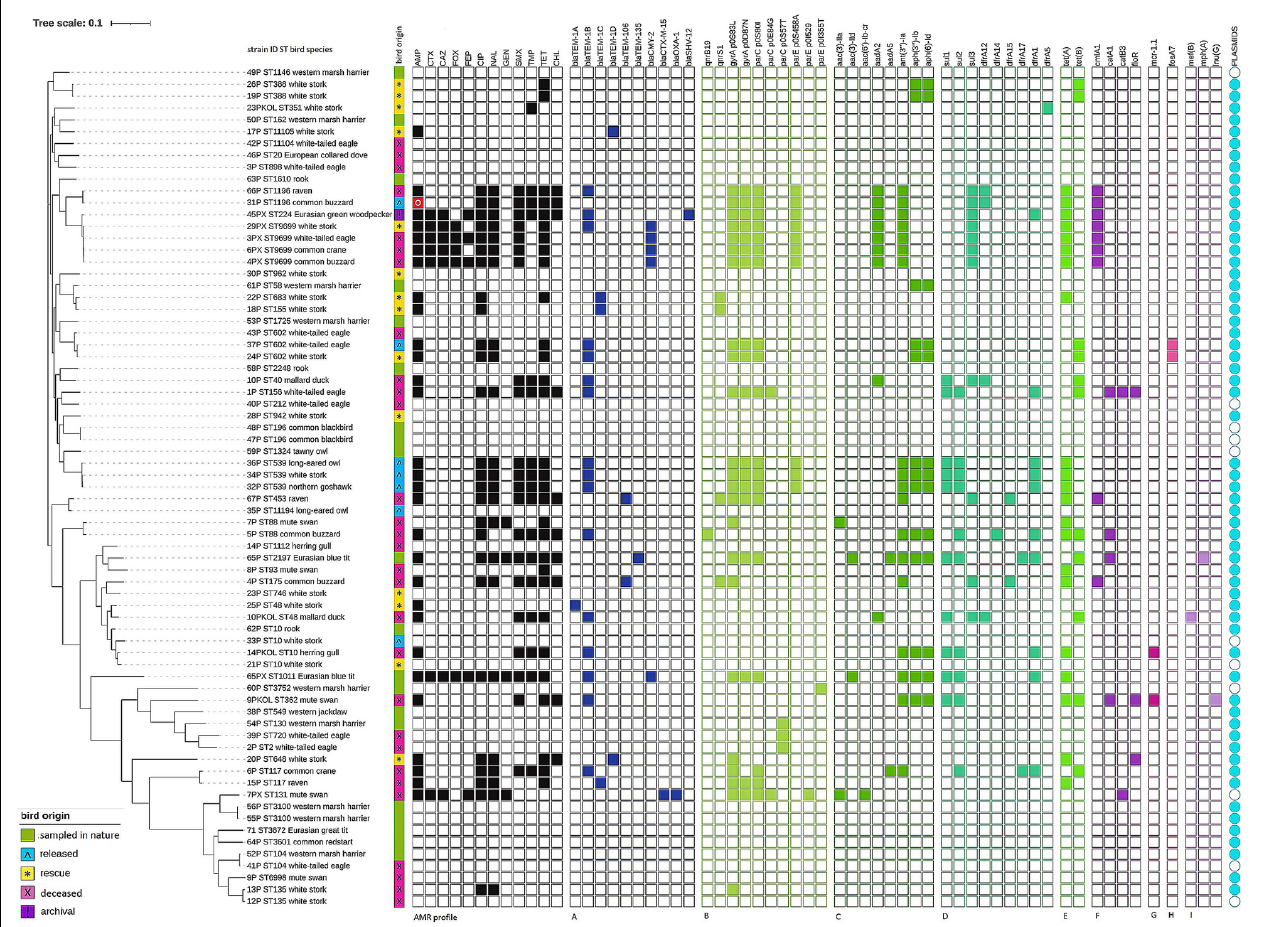
FIGURE 1 | Phylogeny of Escherichia coli strains isolated from wild birds. Full and empty squares depict the presence or absence of AMR or AMR determinants. AMR profile in black—phenotypic AMR profiles confirmed by the presence of AMR determinants. Red square with white circle means phenotypical resistance not confirmed by genotypic testing. (A) Beta-lactam, (B) quinolone, (C) aminoglycosides, (D) folate path inhibitors, (E) tetracyclines, (F) phenicols, (G) colistin, (H) fosfomycin, (I) macrolide and lincosamide resistance determinants. Visualization prepared with the online tool iTOL